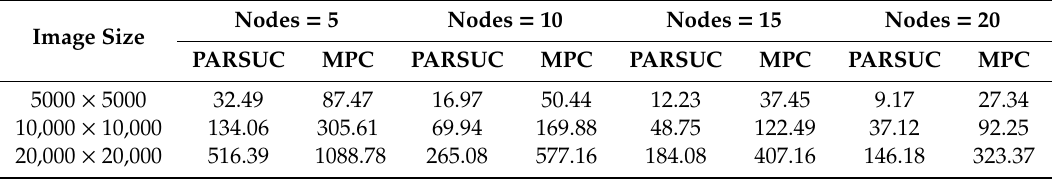
Table 5. Comparison of the processing time (in minutes) between PARSUC and MapReduce-based parallel clustering